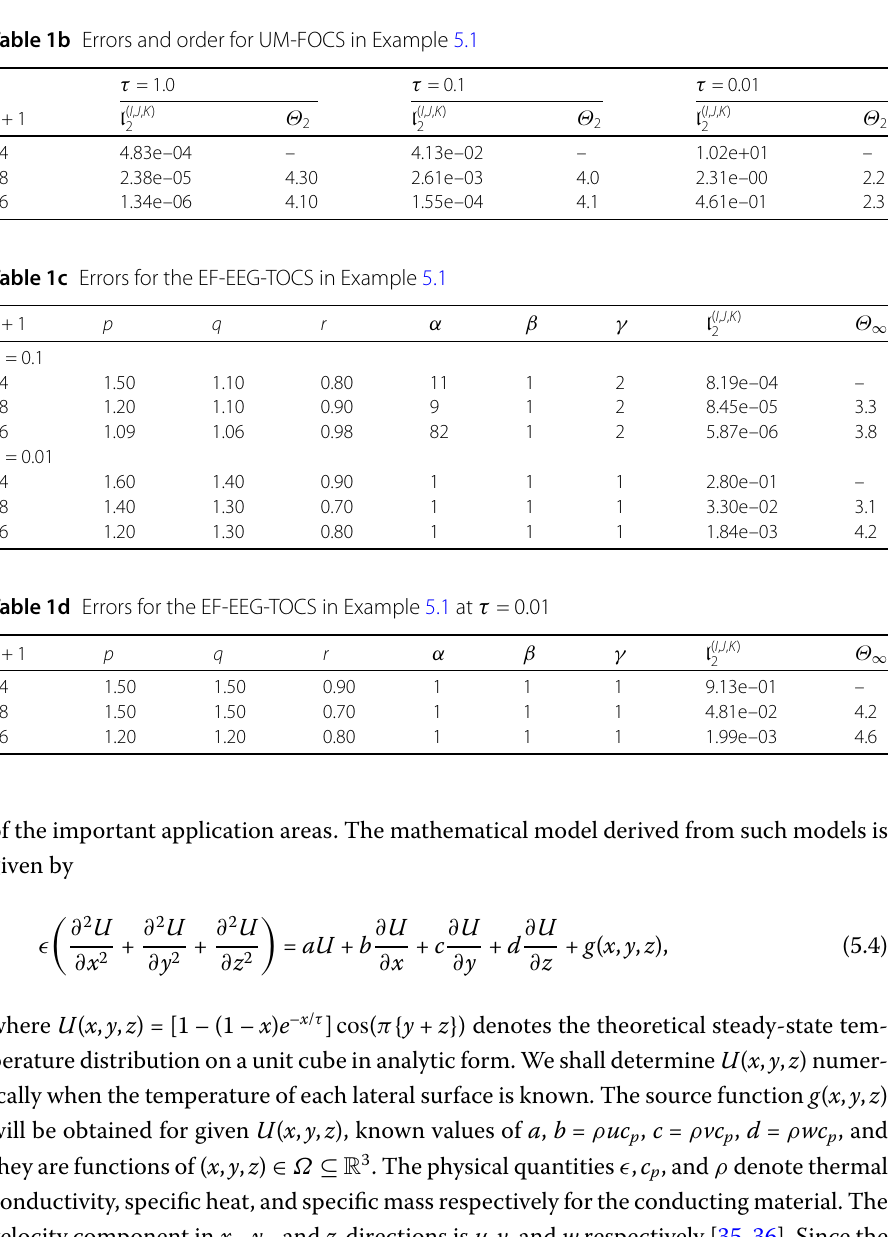
Table 1a with b = c = d = 1 and Table 1b with b = x + y , c = y + z , d = x + z , at τ =